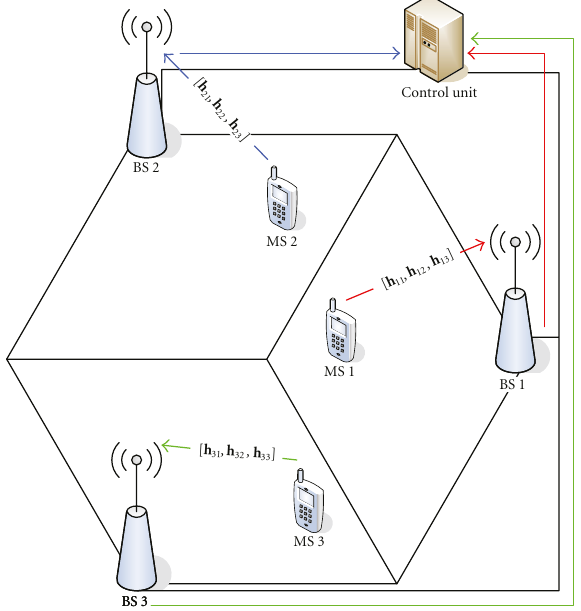
Figure 1: Phase 2 of the typical centralised framework: MSs feed back their CSI to their Master BS, and local CSI is exchanged with a Control Unit. The Control Unit gathers global CSI, performs user scheduling, and designs